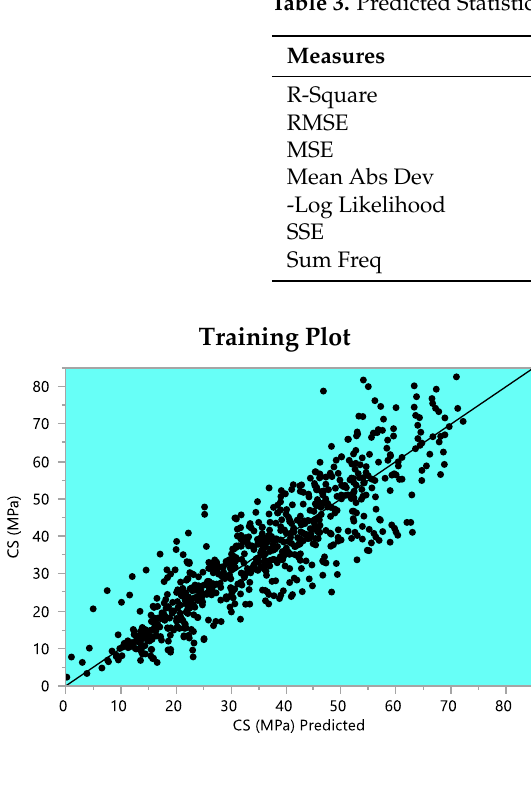
Table 4. Statistical parameter estimations using ANNs modeling.